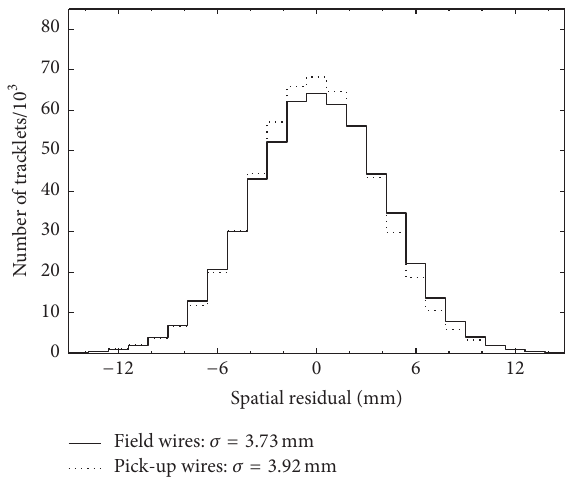
Figure 7: The position resolution of the detector, measured as the distance between the observed hit position and the fitted track intersection (well defined trajectory identified in the tracking system, excluding the detector layer under study). The resolution in both directions is found to be below